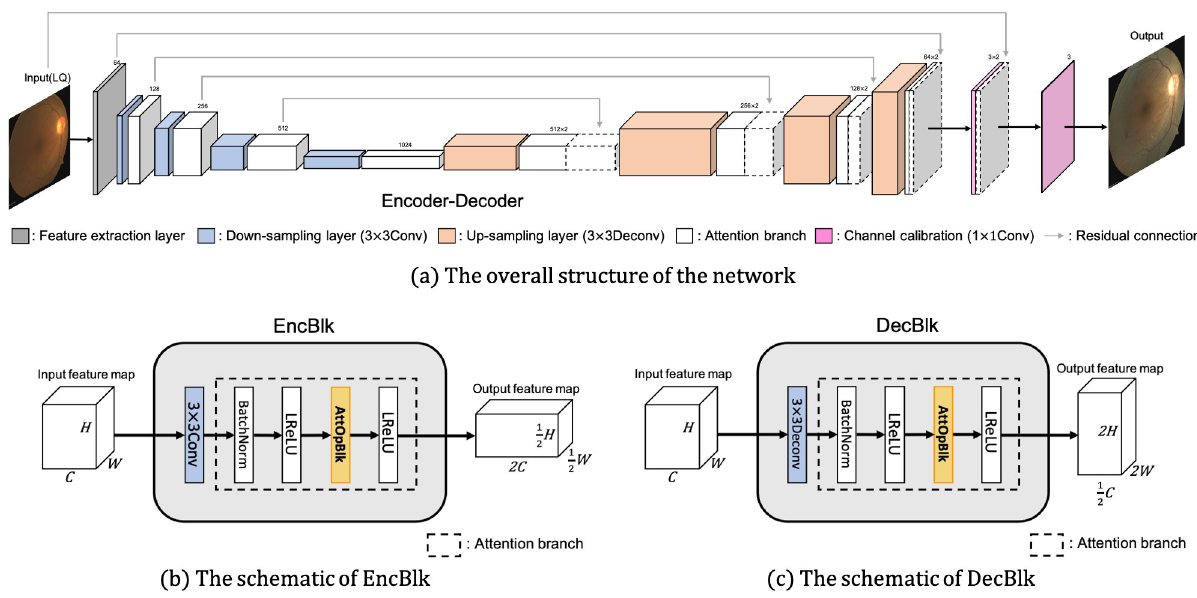
Fig 3. The overall architecture of the proposed method. The first half of the network encodes the fundus image to latent representation; whereas the second half decodes it again to reconstruct the enhanced fundus image. The whole symmetric network is trained in an end-to-end manner.